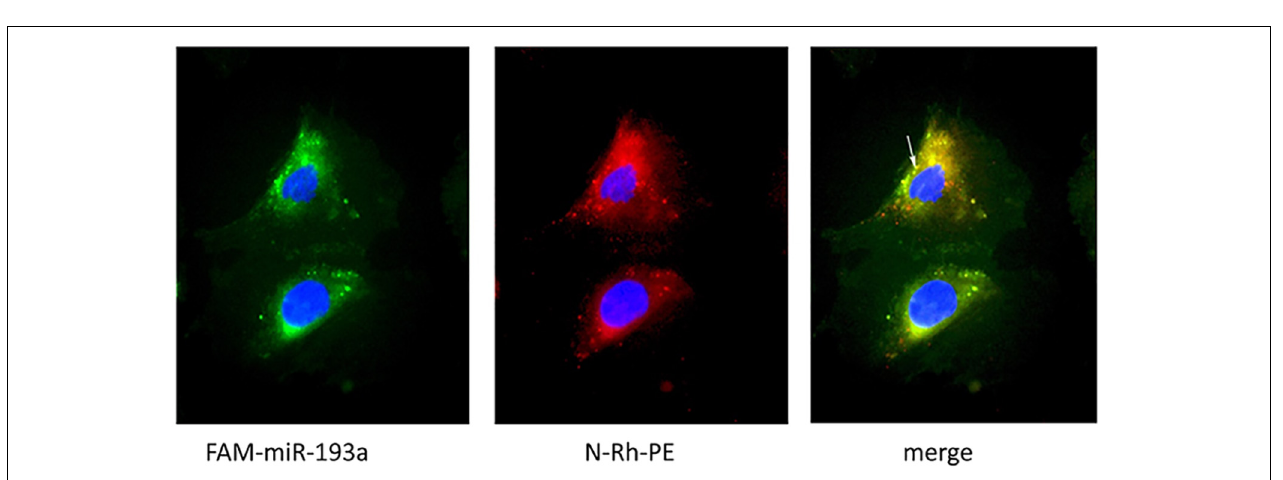
FIGURE 5 | Representative micrographs show renal CD63 staining (IHC, 400 × ). The expression level of CD63 was significantly up-regulated in patients with FSGS compared with TBMD, which was mainly located in the cytoplasm of podocytes within non-sclerotic tuft segments (indicated by black arrows).